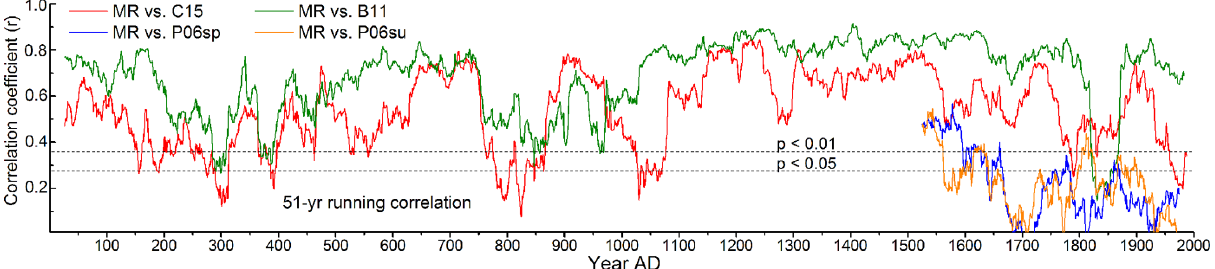
Figure A1. Comparison of MR precipitation reconstruction to other reconstructions of rainfall variability. Statistical comparison (51- year running correlation) between the MR reconstruction and C15 (Cook et al., 2015), B11 (Büntgen et al., 2011) and P06sp/su (Paul- ing et al., 2006).